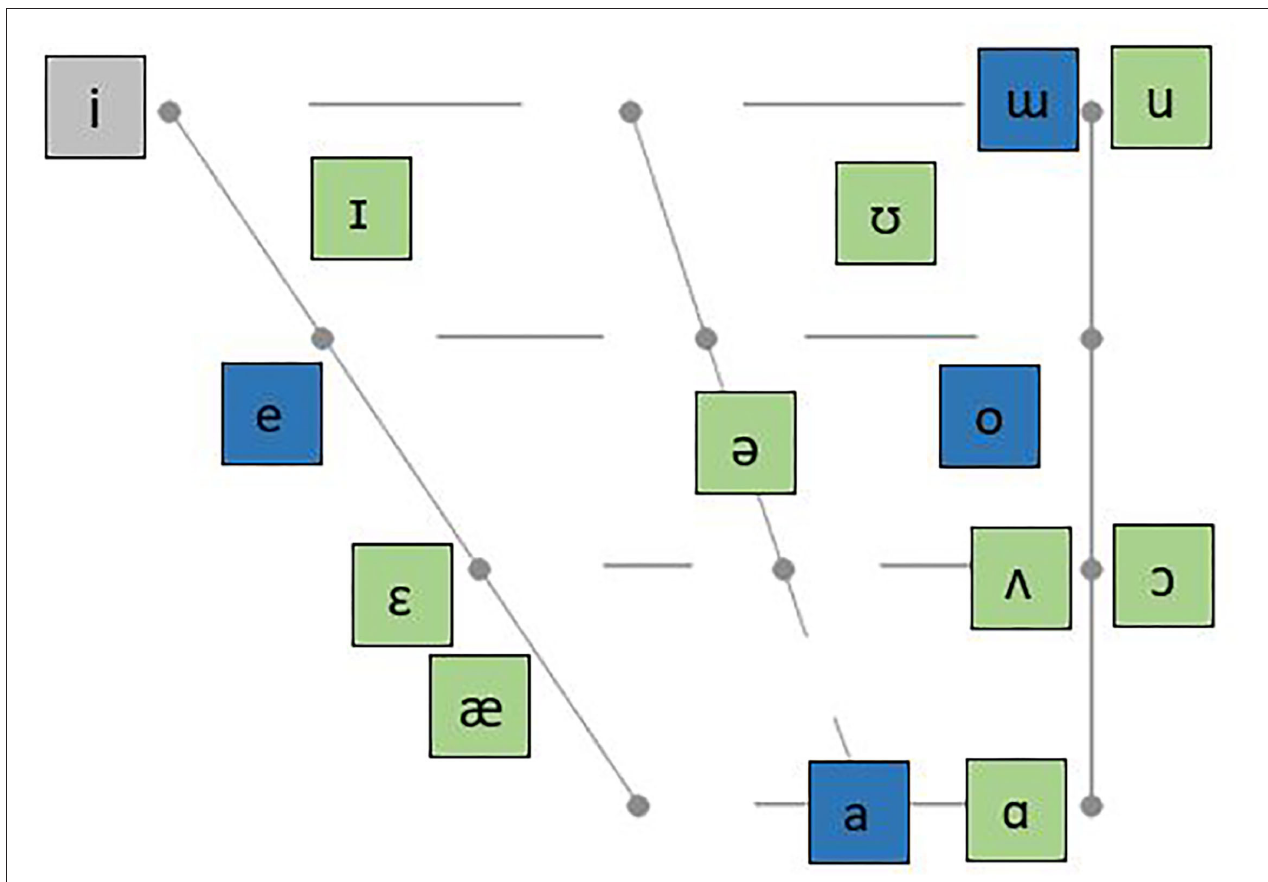
TABLE 1 | English (green) and Japanese (blue) consonant inventories. Bilabial Labiodental Dental Alveolar Alveolo-palatal Postalveolar Palatal Velar Uvular Glottal Plosive k g